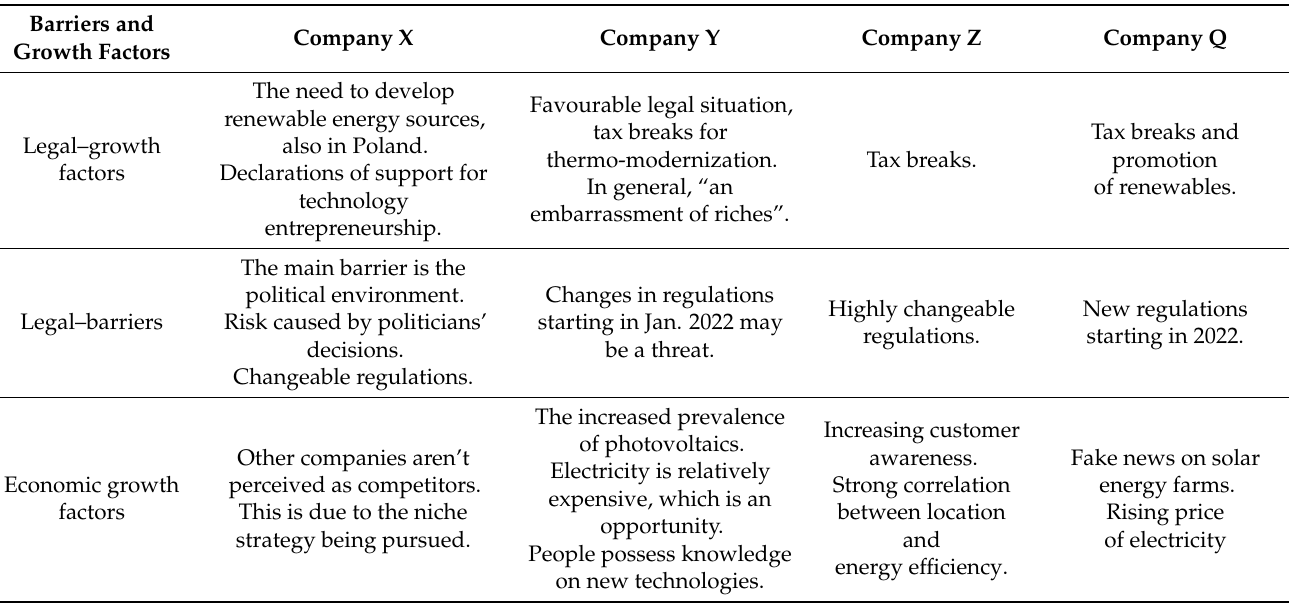
Table 2. Barriers and growth factors in the development of companies in the photovoltaic industry in Poland. Barriers